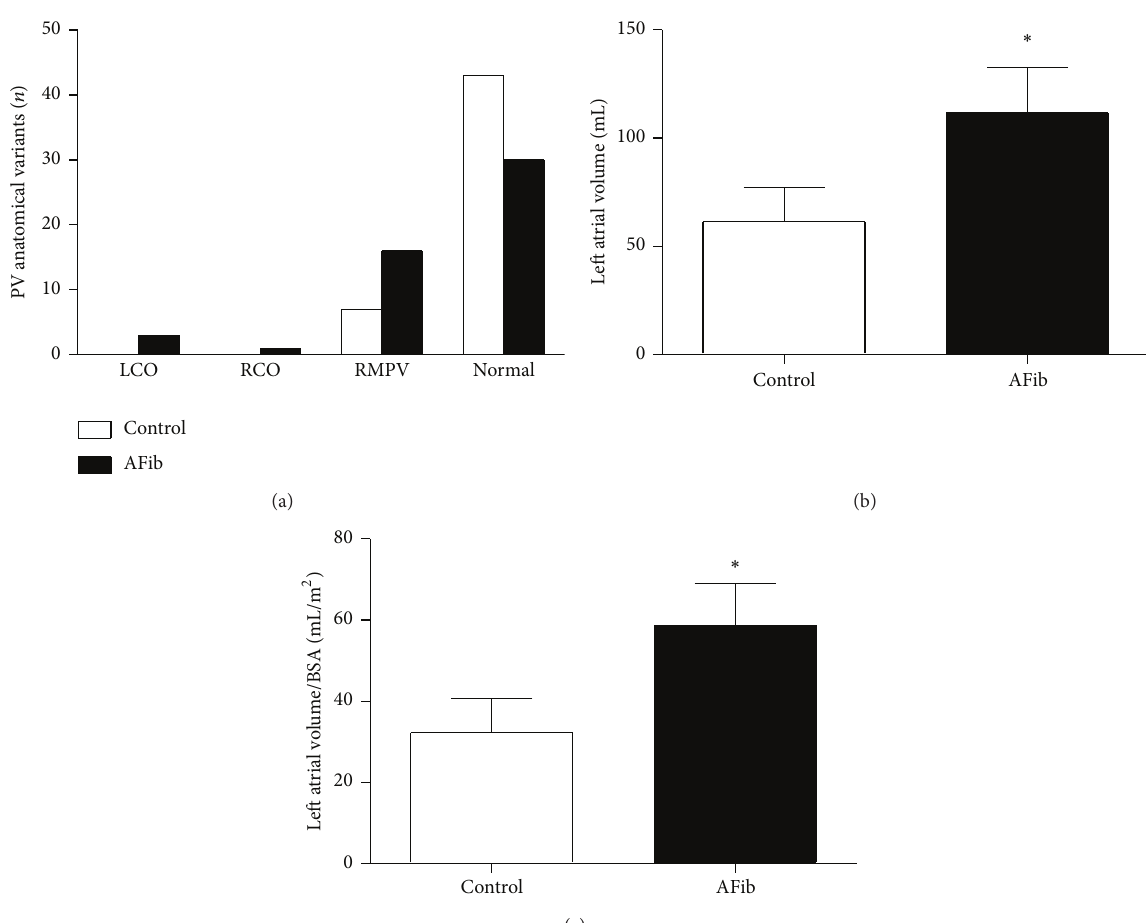
Figure 3: (a) Number of patients with a right middle pulmonary vein (RMPV), common left ostium (LCO), and common right ostium (RCO). Patients with AFib (atrial fibrillation) versus controls with SR (sinus rhythm). 𝑁 = number of patients; total number of patients in each group = 50. (b) Volume of left atrium after exclusion of the pulmonary veins and left atrial appendage. (b) Left atrial volume in controls and patients with AFib. (c) Left atrial volume indexed to body surface area (BSA) in controls and patients with AFib; ∗ 𝑃 < 0.05 .